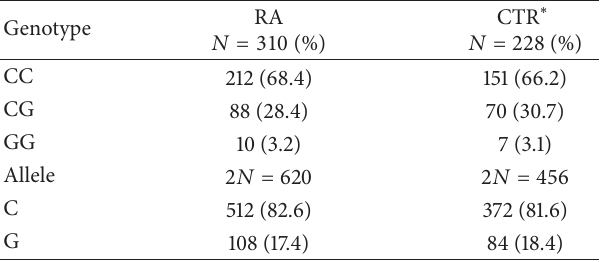
Table 2: GDF15 polymorphism (rs1058587) in Colombian patients with